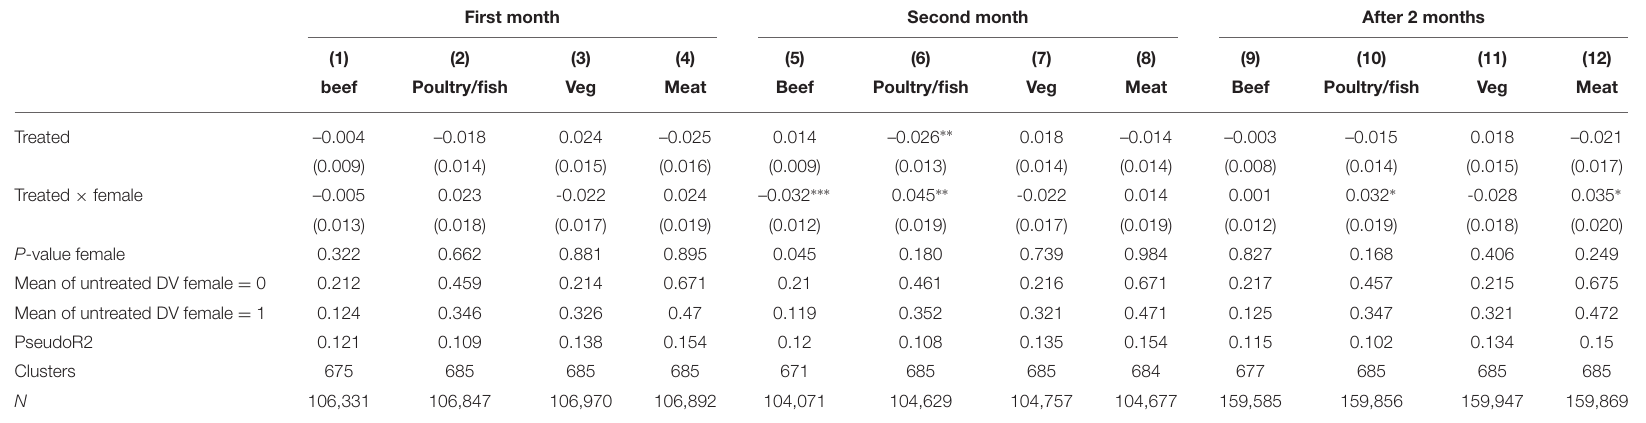
TABLE 3 | Effect of pamphlets by gender–first month, second month, after.